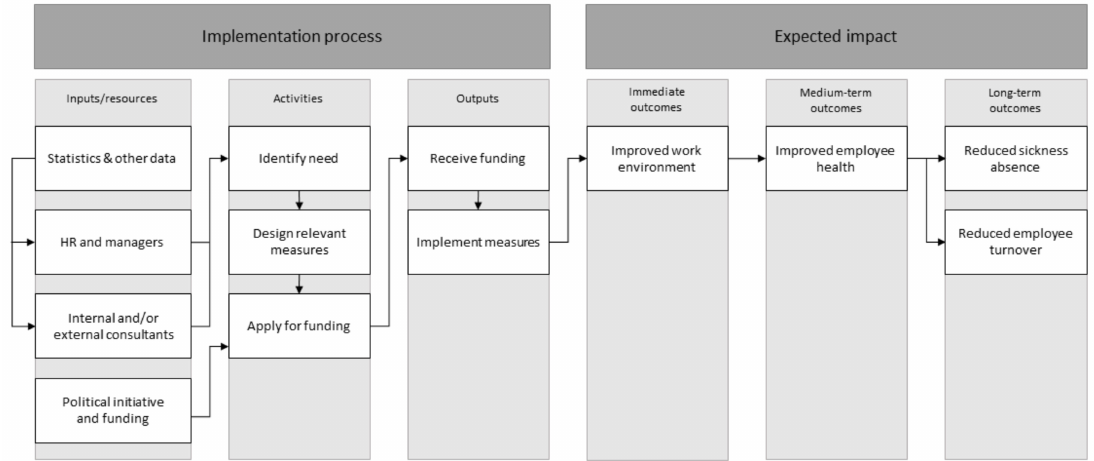
Figure 1. Schematic overview of the logic model of the intervention, focusing on the implementation process and expected